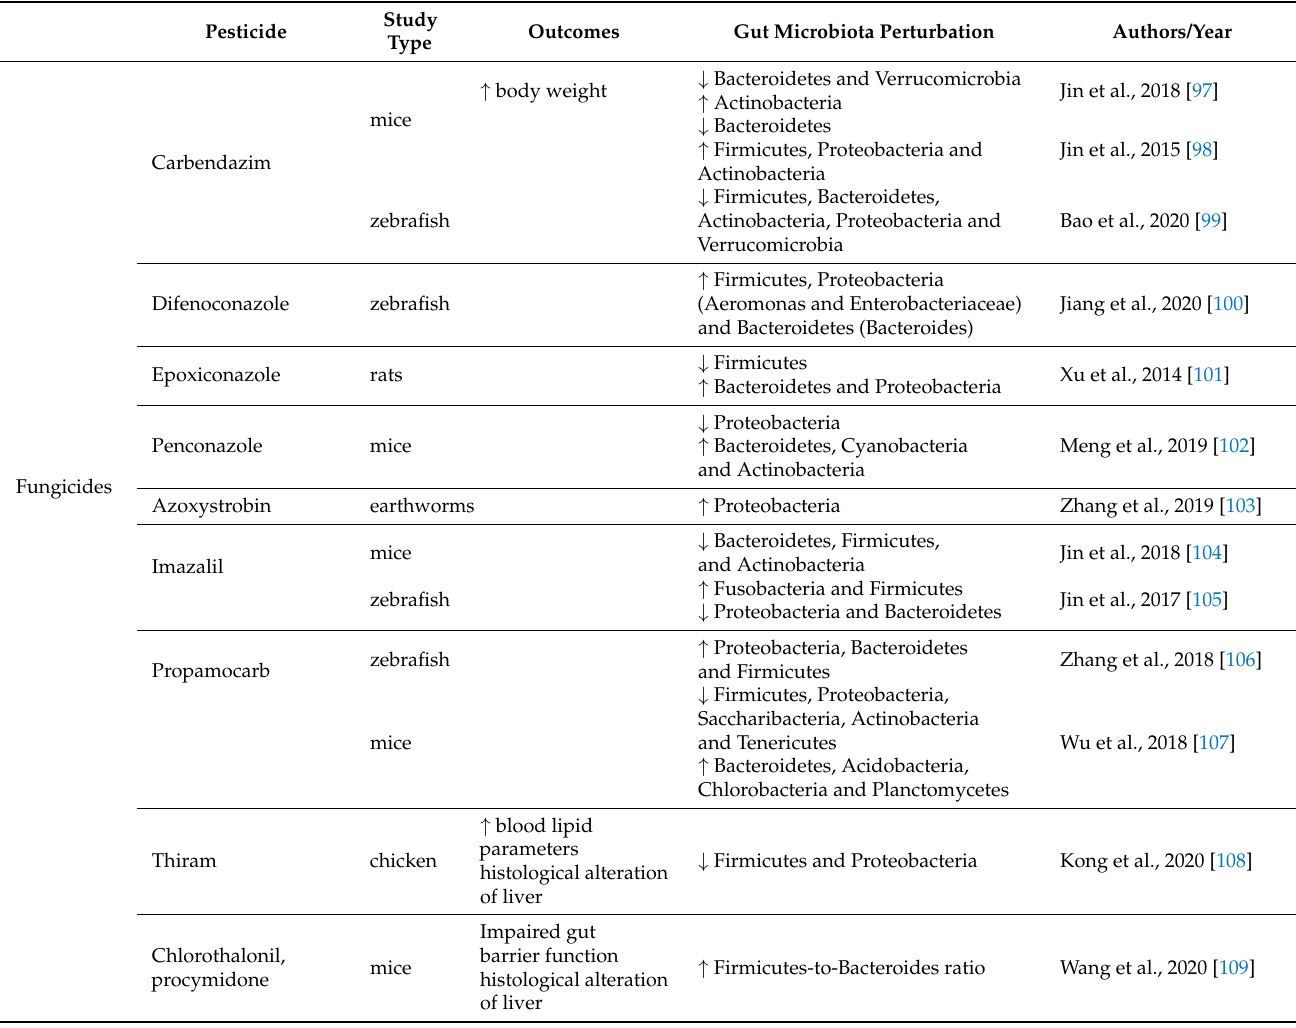
Table A5. Current literature on gut microbiota perturbation due to exposure to